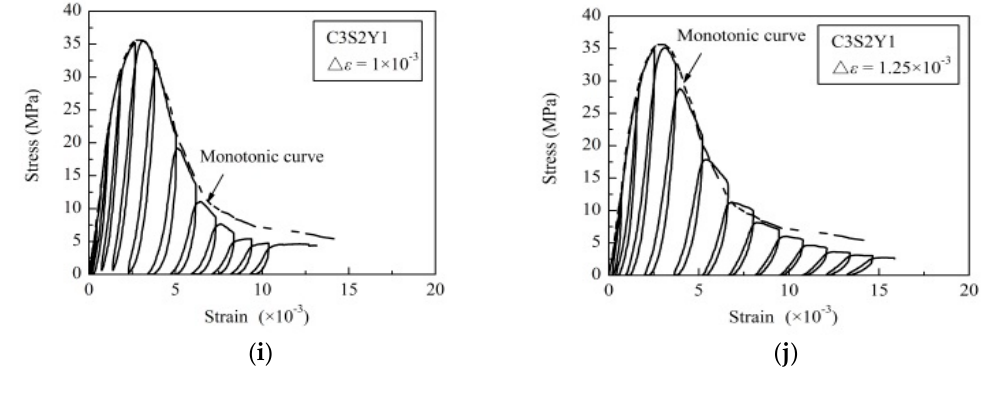
( i ) ( j ) Figure A2. Cyclic stress-strain curves of stirrup-confined concrete specimen: ( a ) C1S2Y1, Δε = 5.00 × 10 − 4 ; ( b ) C1S2Y1, Δε = 1.00 × 10 − 3 ; ( c ) C1S2Y2, Δε = 1.00 × 10 − 3 ; ( d ) C1S2Y2, Δε = 1.25 × 10 − 3 ; ( e ) C2S1Y1, ∆ ε = 1.00 ˆ 10 ´ 3 ; ( f ) C2S1Y1, ∆ ε = 1.25 ˆ 10 ´ 3 ; ( g ) C2S3Y1, ∆ ε = 1.00 ˆ 10 ´ 3 ; ( h ) C2S3Y1, ∆ ε = 1.25 ˆ 10 ´ 3 ; ( i ) C3S2Y1, ∆ ε = 1.00 ˆ 10 ´ 3 ; and ( j )